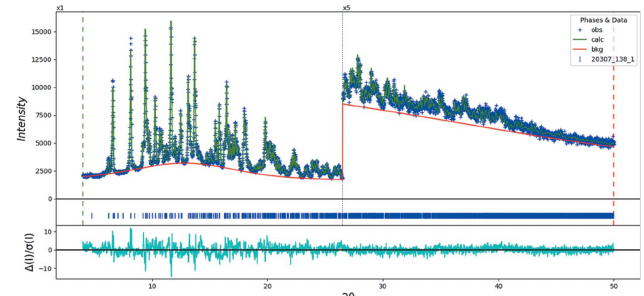
Figure 12 Rietveld plot for (I). The blue crosses represent the observed data points, and the green line is the calculated pattern. The cyan curve is the normalized error plot. The vertical scale has been multiplied by a factor of 5 (cid:7) for 2 (cid:4) > 26.5 (cid:3) . The row of blue tick marks indicates the calculated reflection positions. The red line is the background